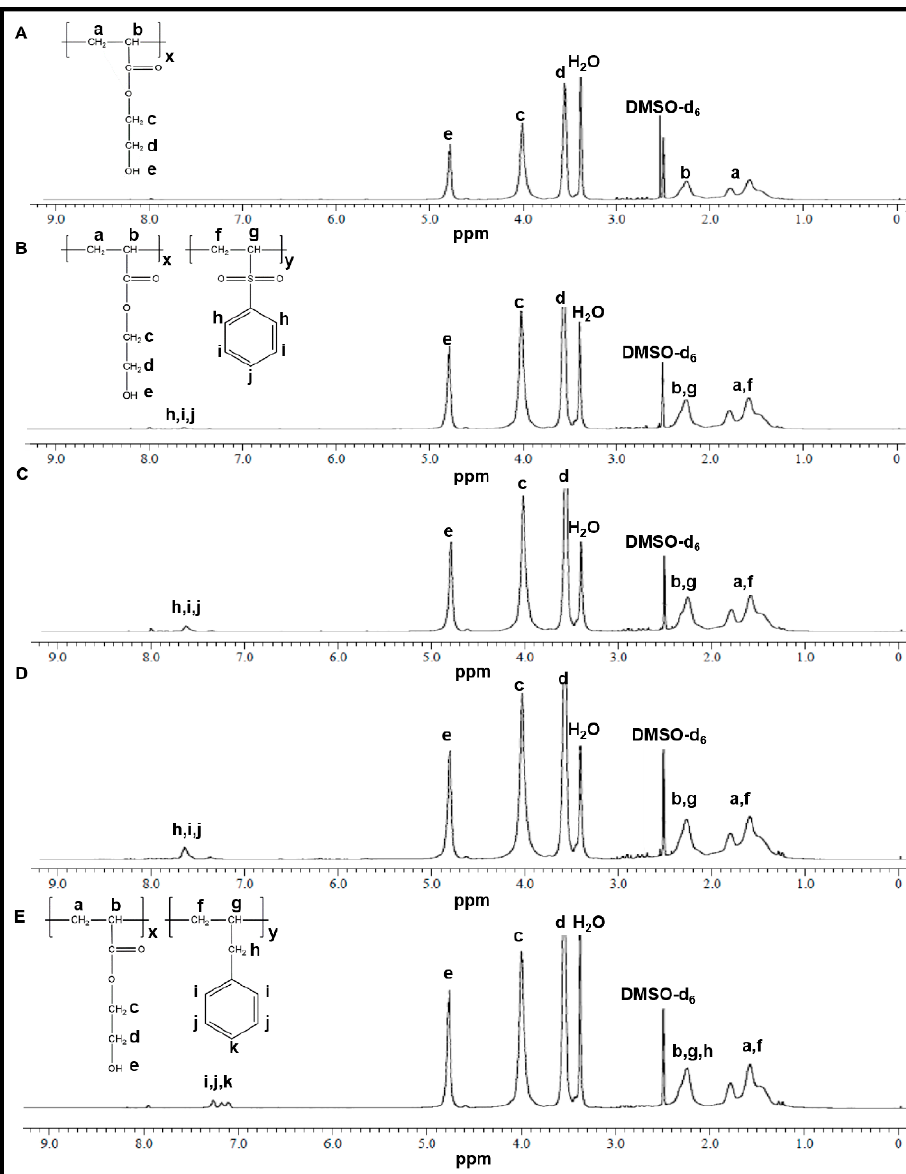
Figure 3. 1 H NMR spectrum of H 2 O 2 -P(HEA- co -PVS)(100 / 0) ( A ), H 2 O 2 -P(HEA- co -PVS)(99 / 1) ( B ), H 2 O 2 -P(HEA- co -PVS)(98 / 2) ( C ), H 2 O 2 -P(HEA- co -PVS)(97 / 3) ( D ), and H 2 O 2 -P(HEA- co -ABZ) ( E ).